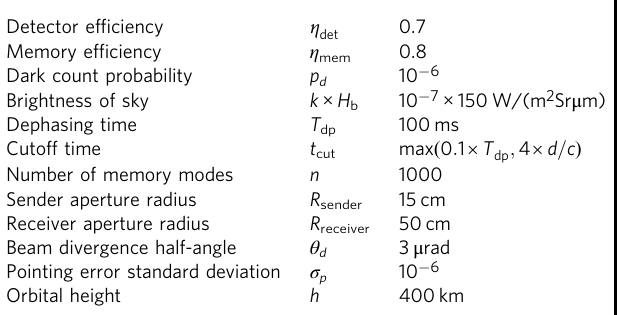
The simulation allows us to explore a range of parameters. These are the base parameters for our simulation that correspond to realistic ranges for current or near-term implementations. All deviations from this set for certain scenarios are highlighted in the text.